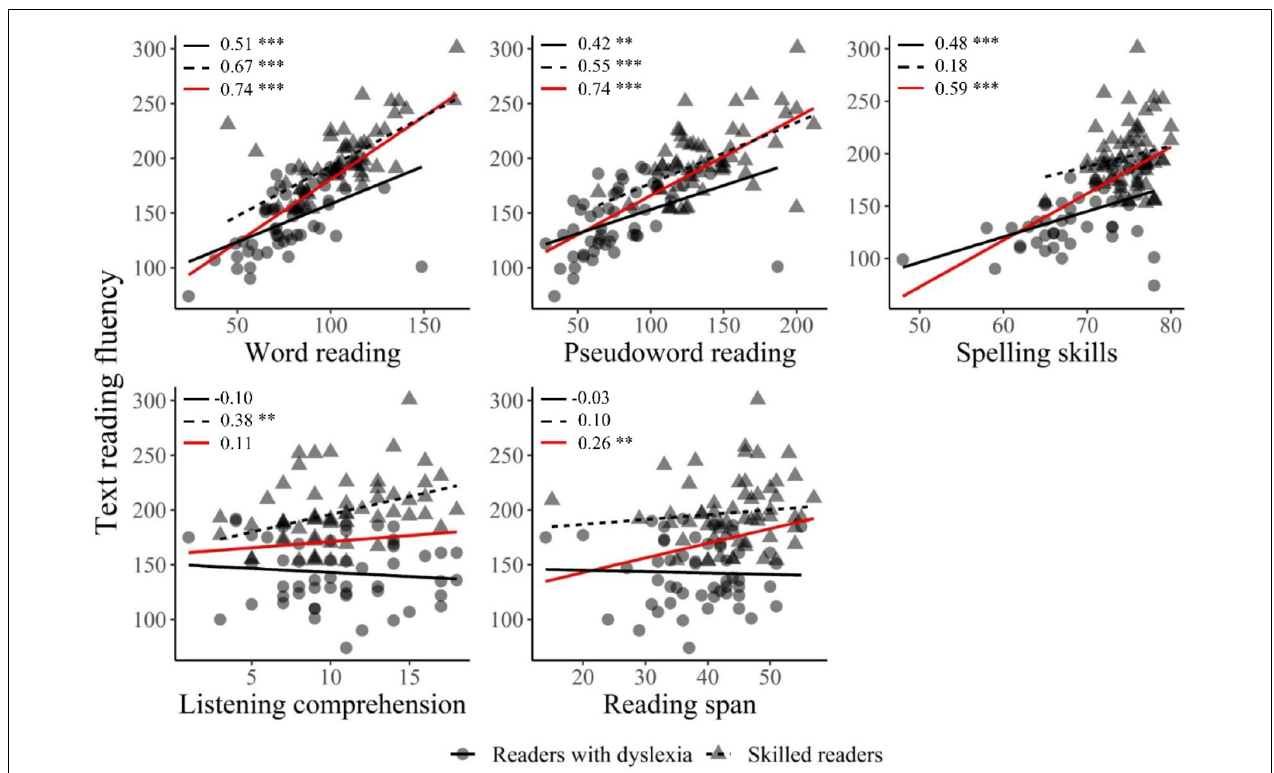
FIGURE 1 | Correlations between TRF and each of the covariates (i.e., word reading, pseudoword reading, spelling skills, listening comprehension, and reading span). Skilled readers are represented by dots, and the corresponding correlation slope is represented by the solid black line. Readers with dyslexia are represented by triangles, and the corresponding correlation slope is represented by the dashed black line. The solid red line represents the correlation slope for the two populations combined. Pearson’s correlations for each slope are indicated in the top left corner of each plot and asterisks represent the significance level of the p -value ( ∗∗ p < 0.01, ∗∗∗ p < 0.001).